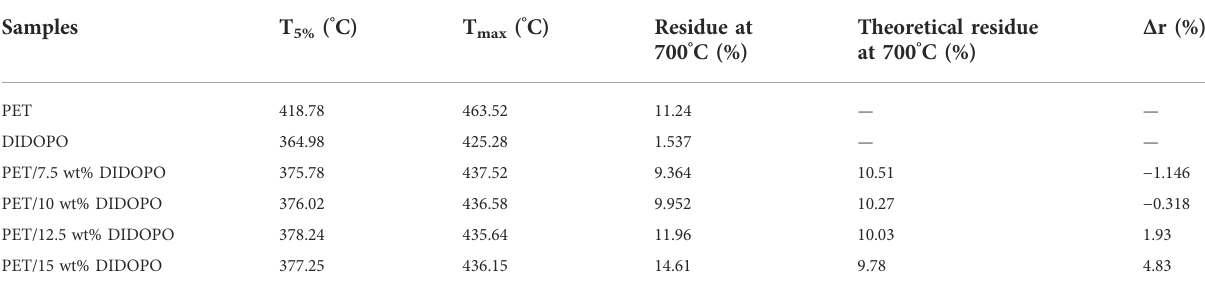
TABLE 2 The TG and DTG date of PET and PET